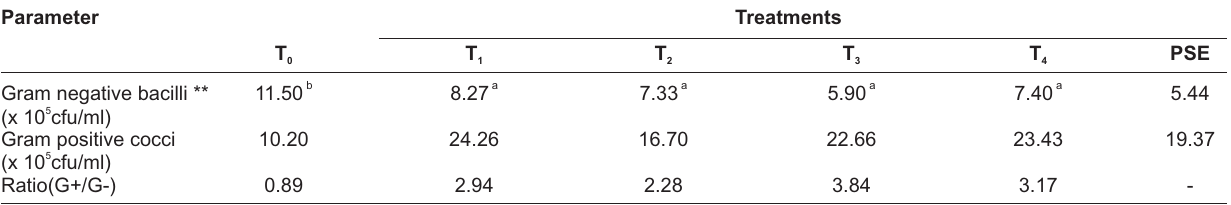
Table-3. Blood plasma concentration of Ca, P and cholesterol in broiler chicks supplemented with Enterococcus strain Parameter